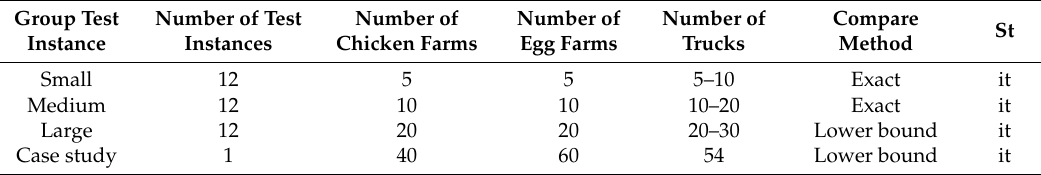
Table 16. Details of the test instances.